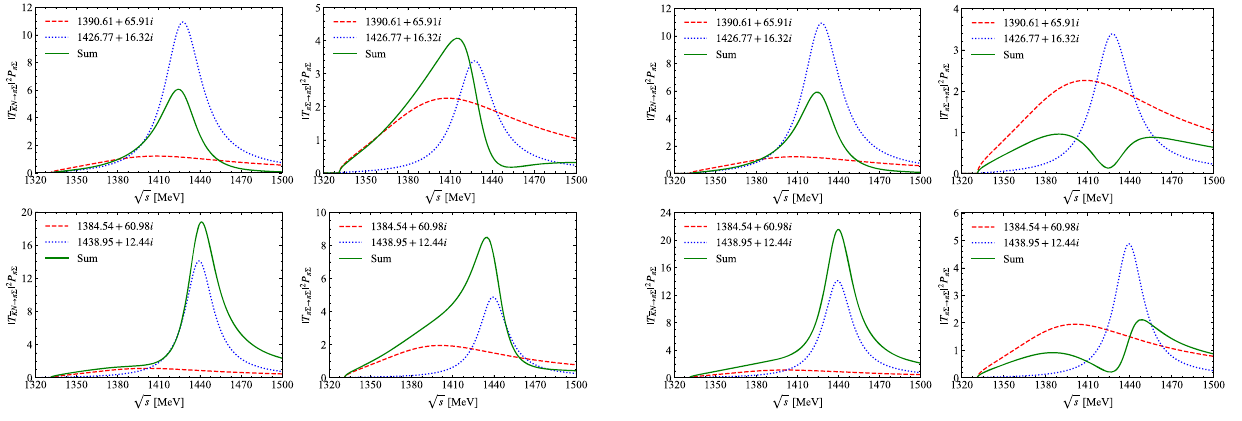
Fig. 5 π(cid:4) spectrausingBreit-WignerparameterizationwithEqs.(20) and (21) for four coupled channels (upper) and two coupled channels (lower) ¯ K N is strong enough to bound a state. Whereas, the one of √ s p = 1380 . 75 + 80 . 95 i appears in the second Riemann of